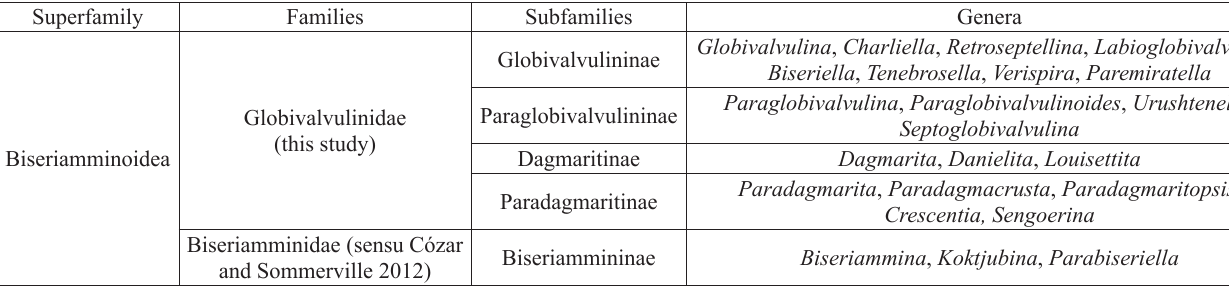
Table 1. New taxonomic arrangement of the family Globivalvulinidae proposed in this paper. Superfamily